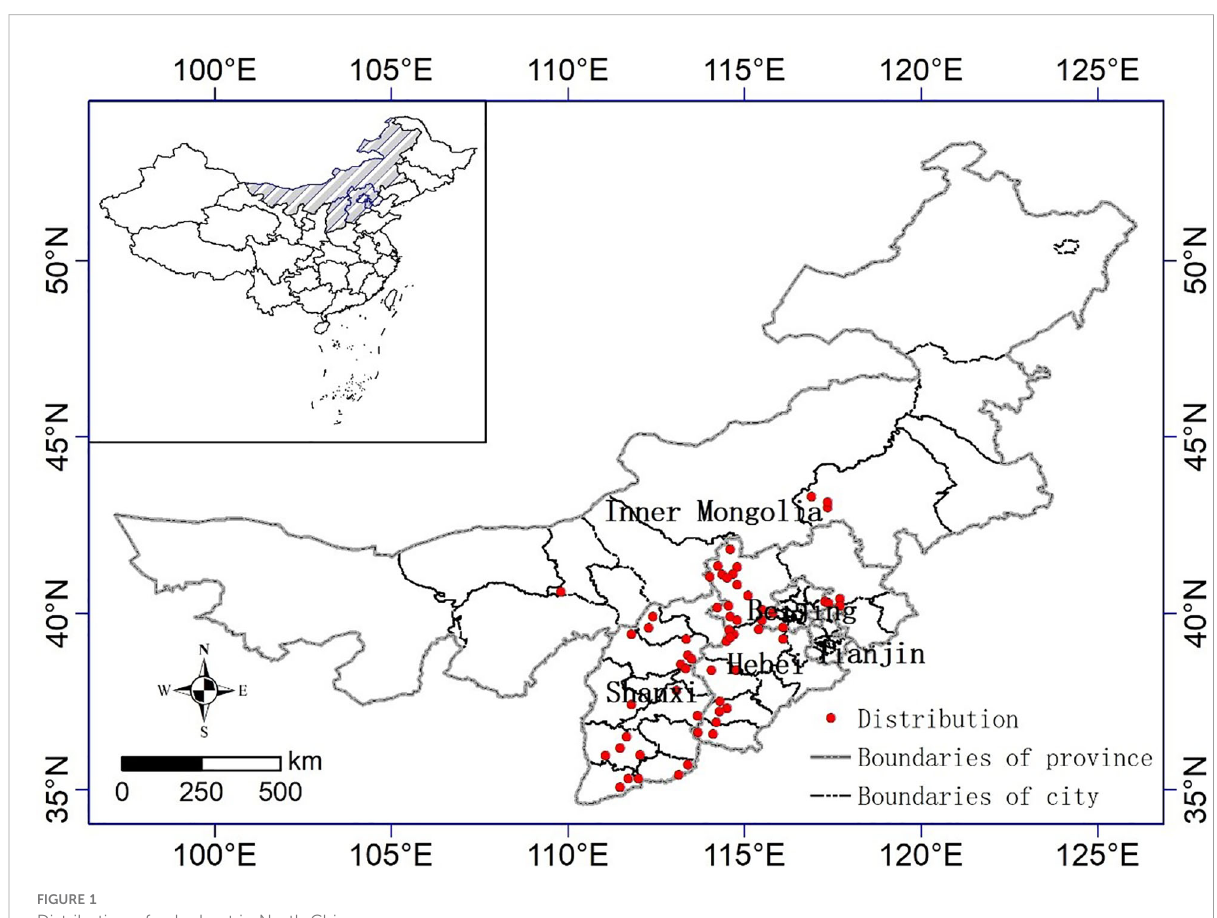
FIGURE 1 Distribution of naked oat in North